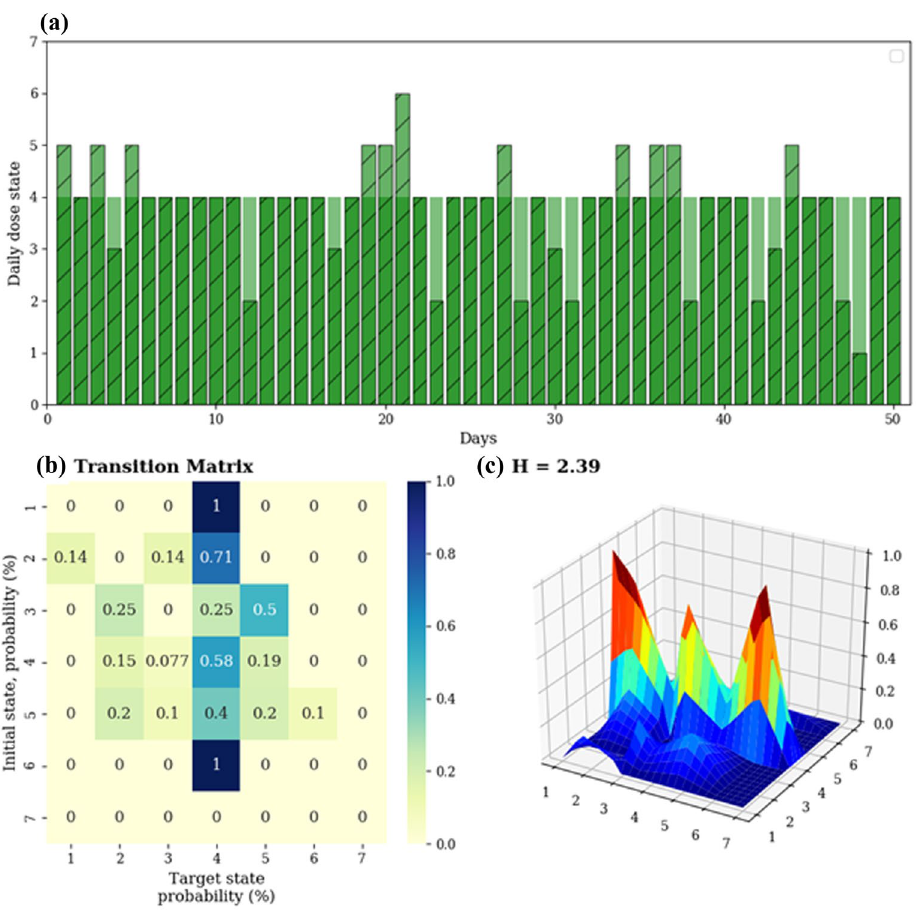
Figure 2. Calculation of entropy. Panel ( a ) shows a perfectly-adherent time series (green) in the background comprising 100% of prescribed puffs for 100% of the time, and an example patient time series (blue) overlaid atop the perfectly-adherent series, with instances of under- and over-adherence, both mapped to the state-based series. Panel ( b ) displays the corresponding transitional probability matrix, while panel ( c ) allows us to visualise the same matrix (and the “disorder”) in a 3-dimensional graph. The entropy of the transitional probability − 1 P i , j ( − ln ( P i,j )) . (Python Software Foundation, version 3·6 http:// www. python. matrix is then calculated as (cid:31) N i , j = 0